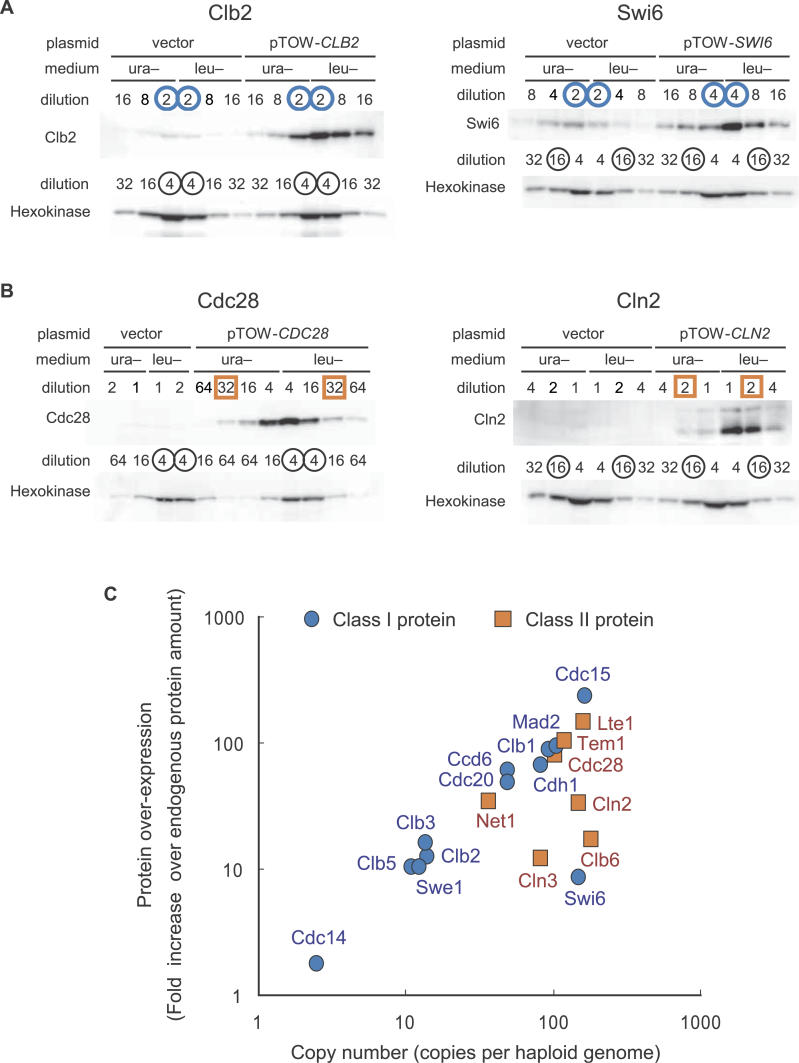
Quantification of the Protein Level Expressed in the gTOW Experiment(A) Typical example of the Western blots in Class I genes. Circled samples were used for the measurement of each protein bands.(B) Typical example of the Western blots in Class II genes. Squared samples were used for the measurement of each protein bands.(C) Scatter plot between the protein overexpression level and the gene copy number (plasmid copy number plus 1) in the gTOW experiment. The data were determined in the conditions with 100 μg/ml (CDC14), 20 μg/ml (CLB2, CLB5, and SWE1), and 30 μg/ml (CLB3) leucine conditions. The data used in the graphs are listed in Table S5.